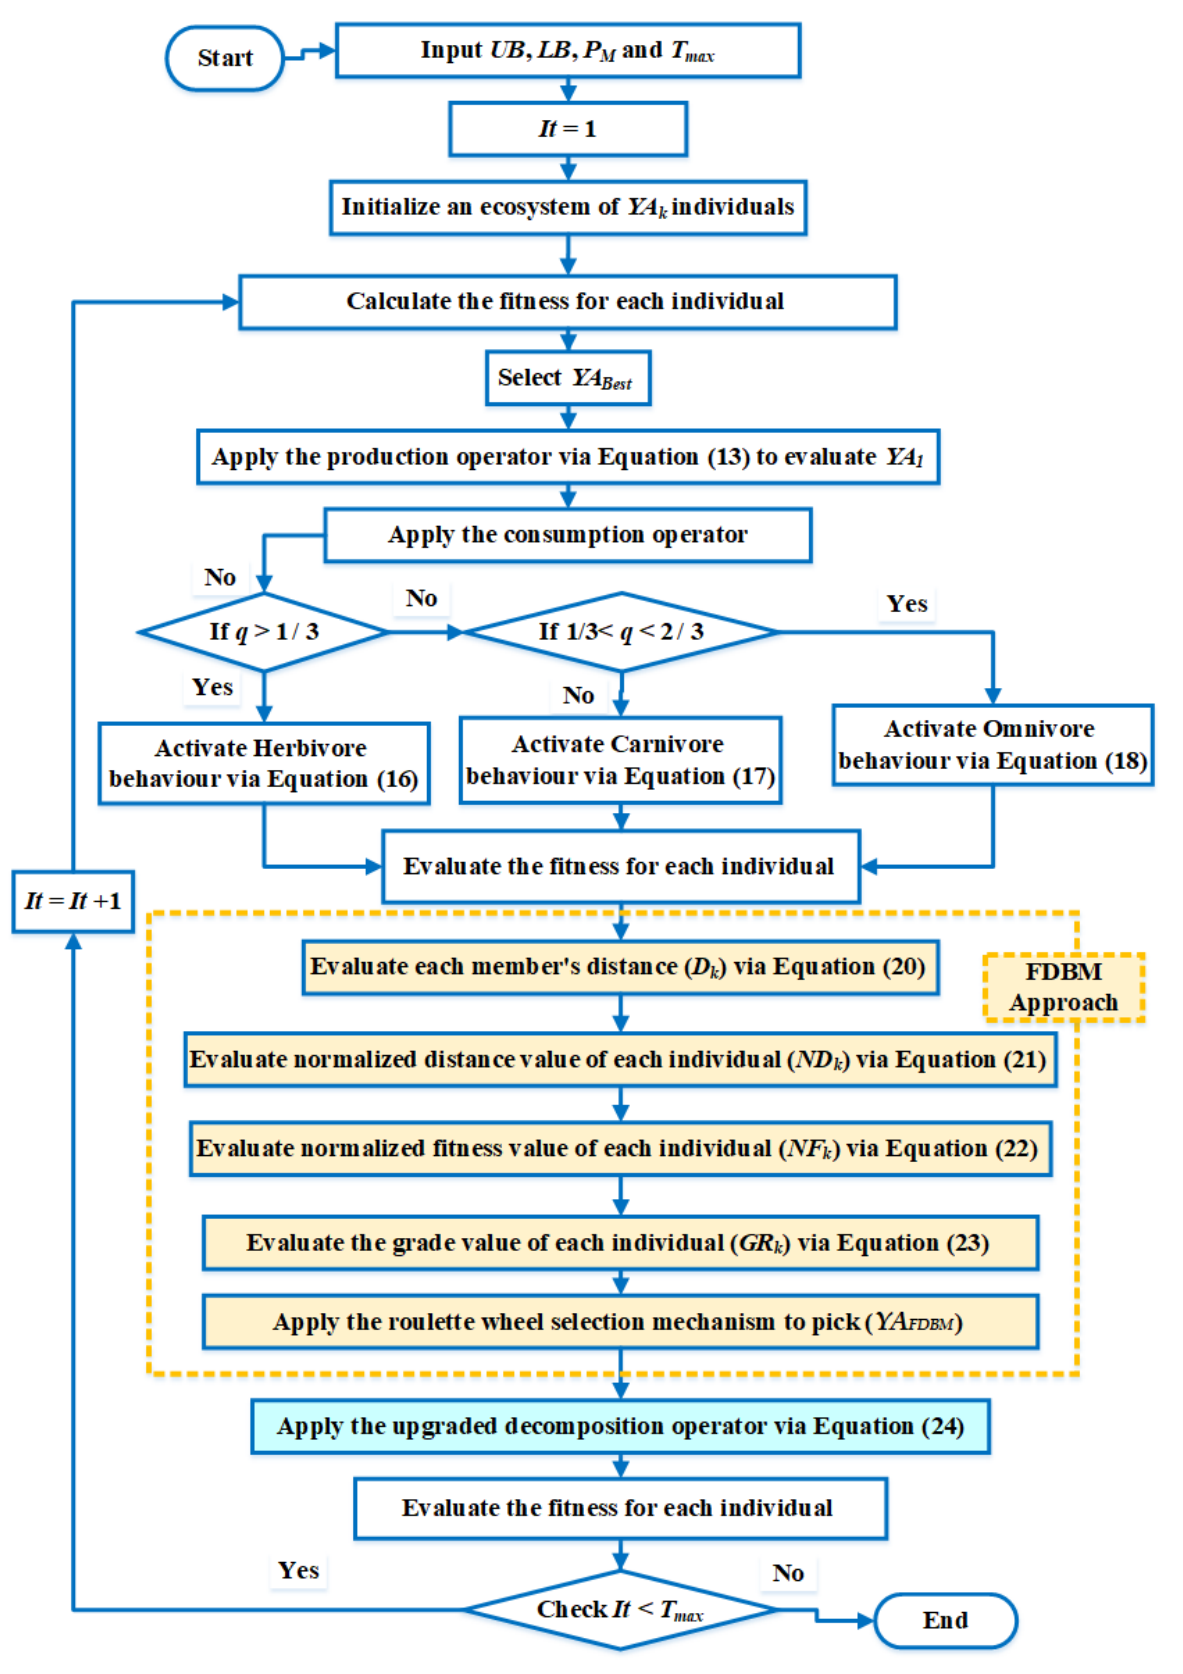
Figure 3. Main steps of the proposed MAEA.